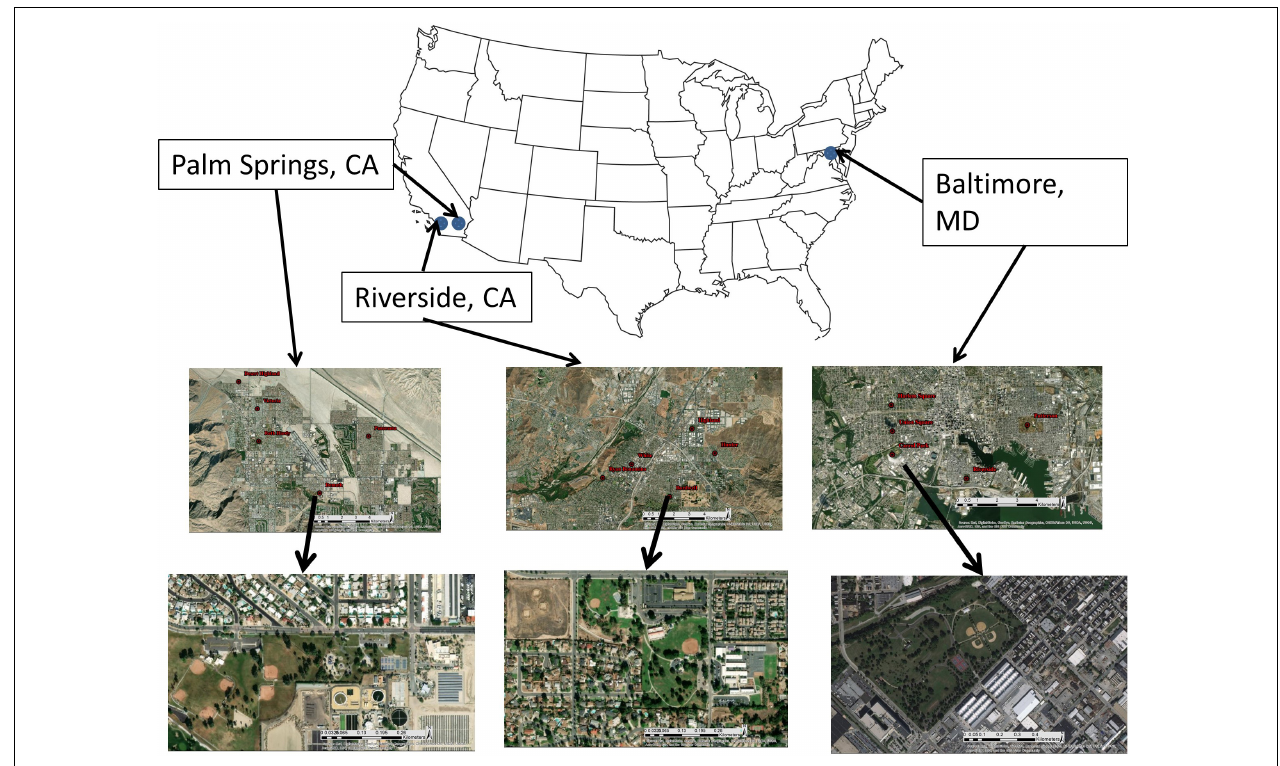
FIGURE 1 | Study area of cities of interest. Five recreational parks were sampled in each city. All parks are representative of a recreational park typology, comprising expansive lawns and individually planted trees. Images are sourced from Google Earth